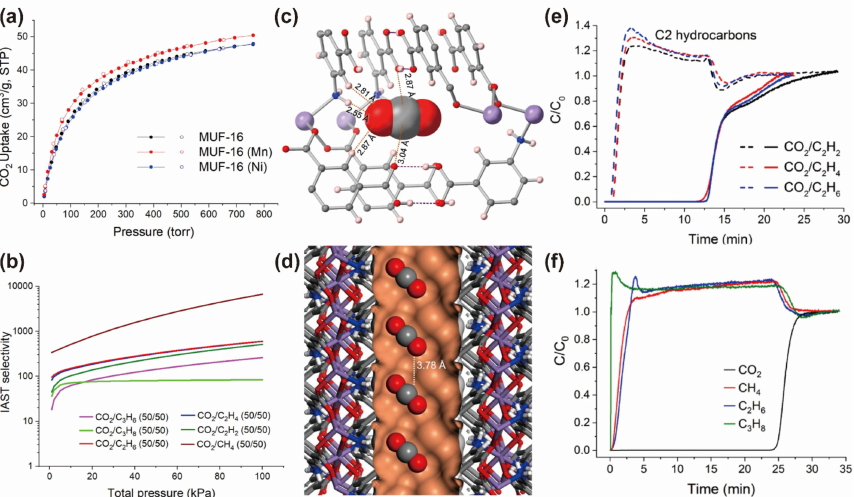
Figure 11. ( a ) The adsorption/desorption isotherms for CO 2 at 293K. ( b ) IAST selectivities of MUF- 16 for different mixtures (50/50) at 293K. ( c , d ) The adsorption sites ( c ) and arrangement ( d ) of adsorbed CO 2 molecules in MUF-16(Mn). Color codes: Mn, lilac; N, blue; O, red; C, gray; H, light pink or white; pore surface, orange. ( e , f ) Breakthrough experiment curves for CO 2 /C 2 (50/50) ( e ) and CO 2 /CH 4 /C 2 H 6 /C 3 H 8 (15/80/4/1) ( f ) at 293K and 1.1bar for MUF-16. Reproduced with permission from Qazvini et al., Nature Communications; published by Springer Nature, 2021